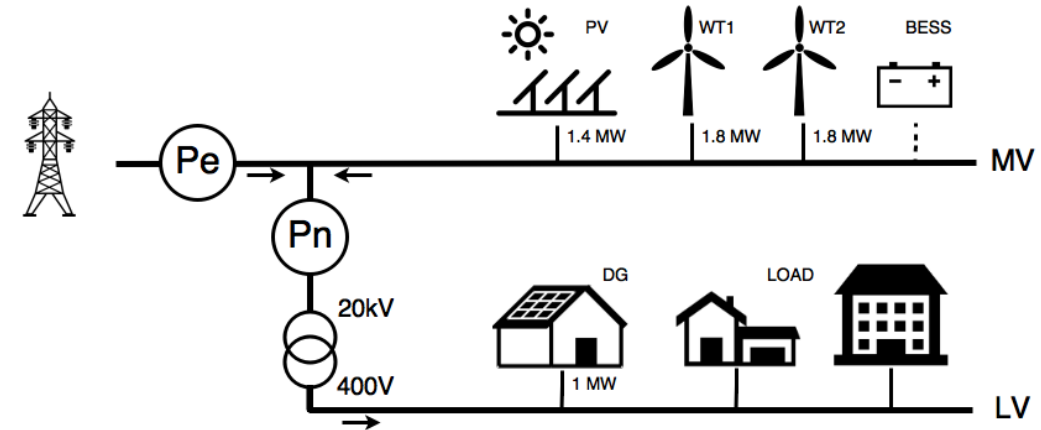
Figure 1. Scheme of the grid in Borkum. A photovoltaic (PV) power plant and two wind turbines are connected to the medium-voltage (MV) line. An energy storage system will be connected to the MV line in the future. The low-voltage (LV) line distributes power to the town, where several PV devices are connected. The available power measurements are relative to the total power exchange with the mainland ( p e ) and to the LV net load ( p n ). BESS: battery energy storage